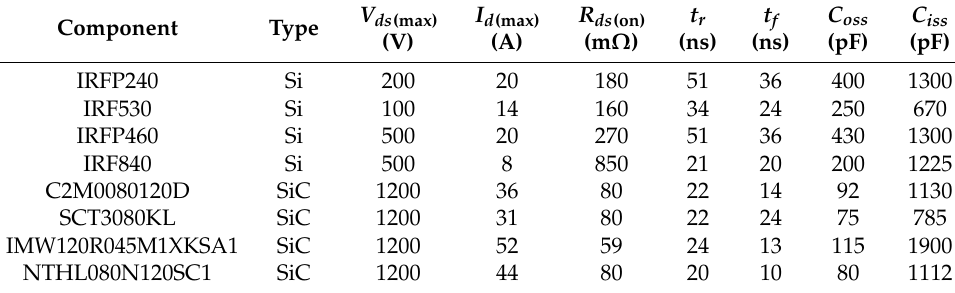
Table 1. Comparison of the characteristics of different MOSFETs.